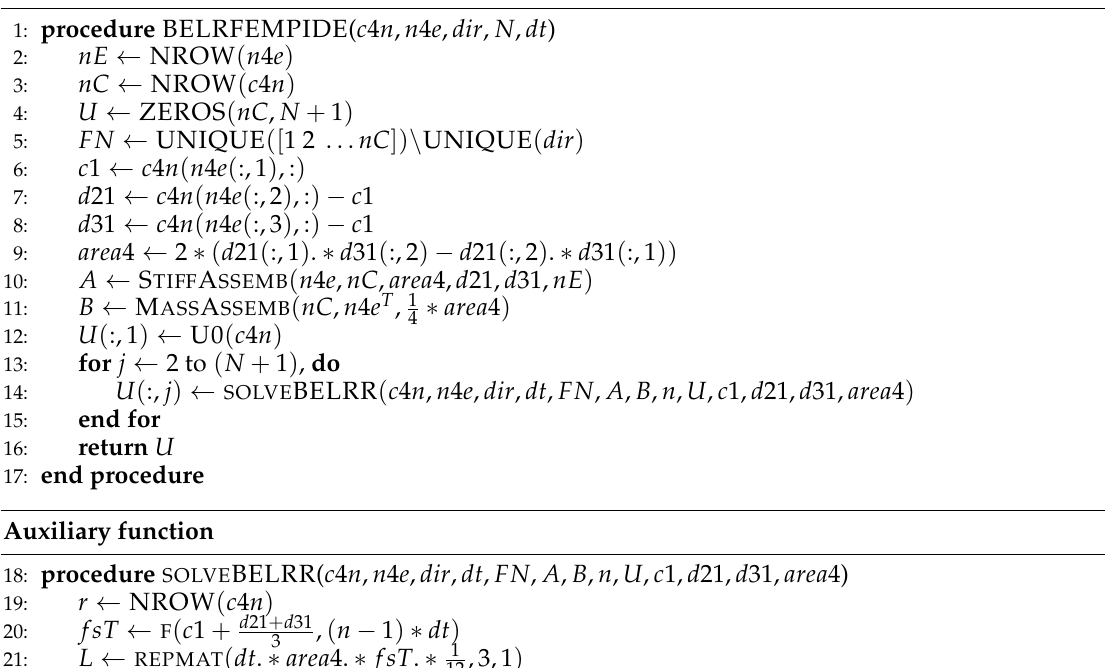
Algorithm A4 Vectorized version of backward-Euler scheme with the left rectangular rule. Main